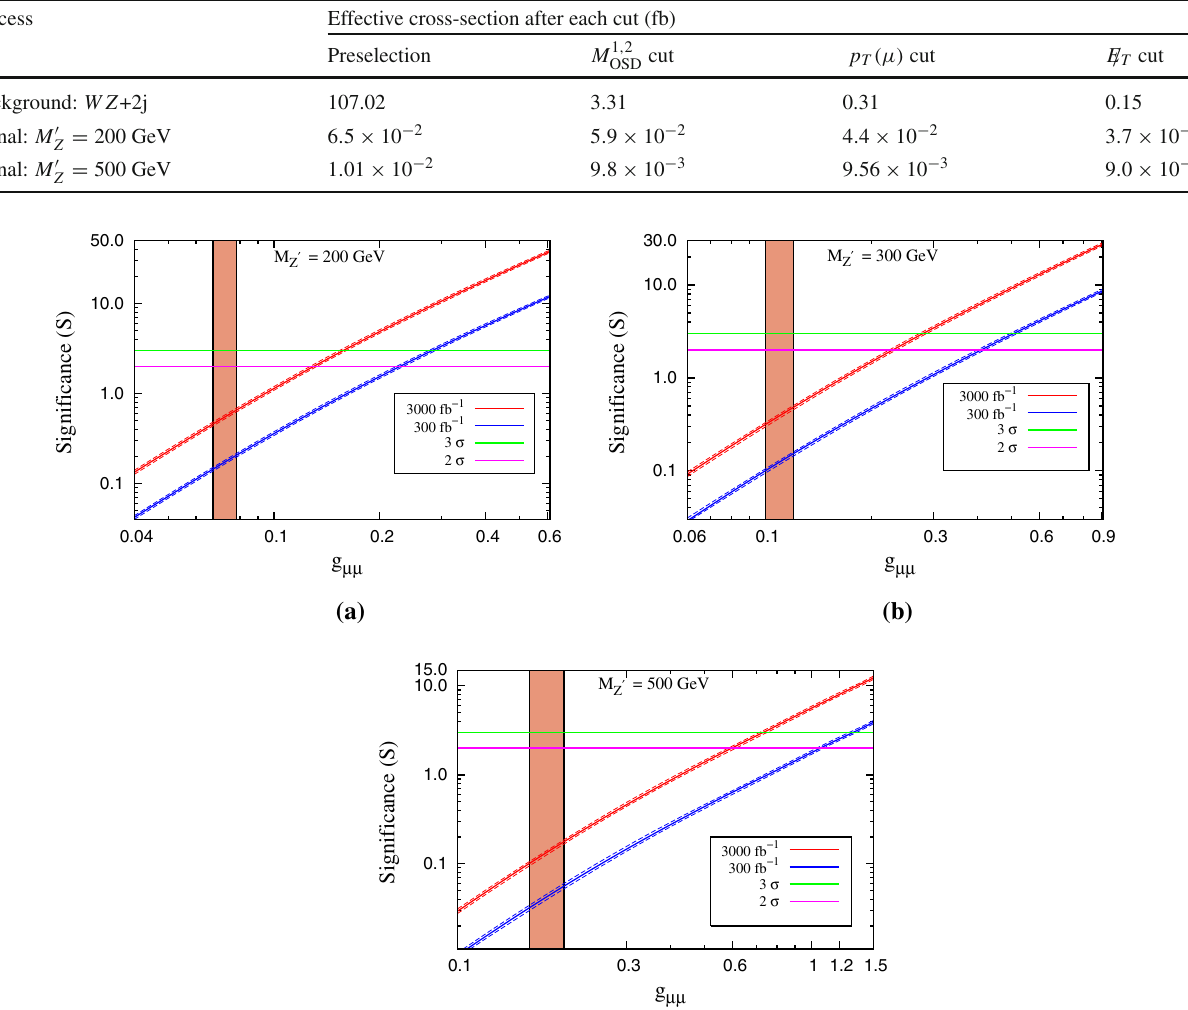
after including systematics ∼ 10% in the background estimates. The √ s = 14 TeV. dark shaded region is the one allowed at 1 σ CL by combining the con- straints from B -meson anomalies, neutrino trident and B → D ∗